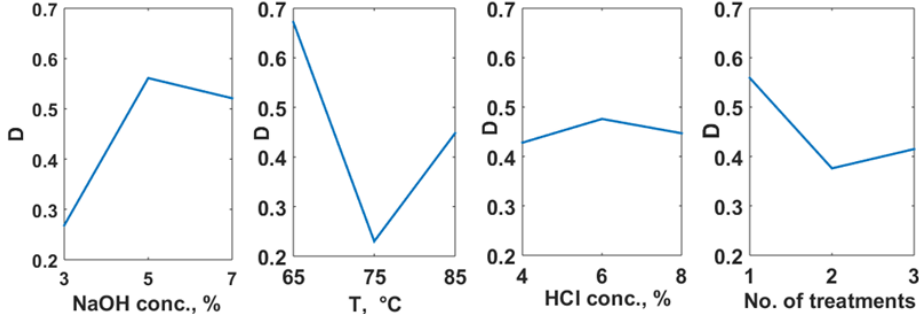
Figure 3. Factors influence for chitin extraction aiming to obtain maximum deacetylation degree and maximum molar mass in chitosan.